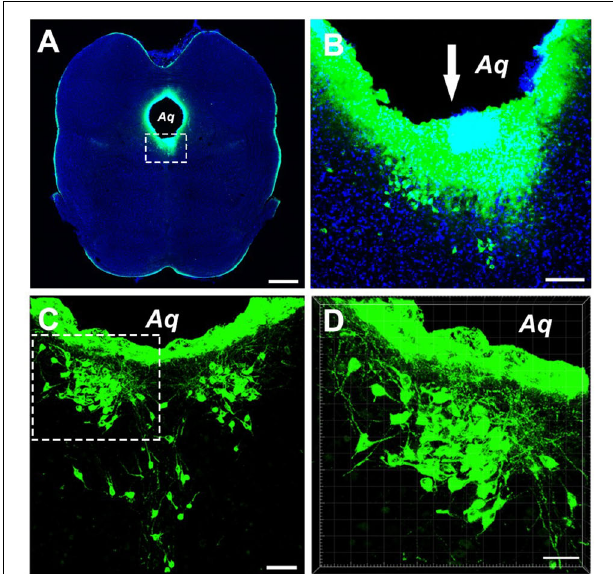
FIGURE 1 | Photographs showing injection of the tracer CB into the CSF-contacting nucleus. (A) The site of injection of tracer CB into the CSF-contacting nucleus. Green fluorescence labeling of CB can be seen in the wholly CSF-contacting nucleus. (B) Higher magnification of the boxed area in (A) . Downwards arrow ( ↓ ) shows the passage of the injected needle. (C) The representative section of the CSF-contacting nucleus in the brain. (D) Higher magnification of the boxed area in C . Aq, aqueduct. Scale bar = 1 mm in (A) , 100 µ m in (B) , 70 µ m in (C) , and 40 µ m in (D) .